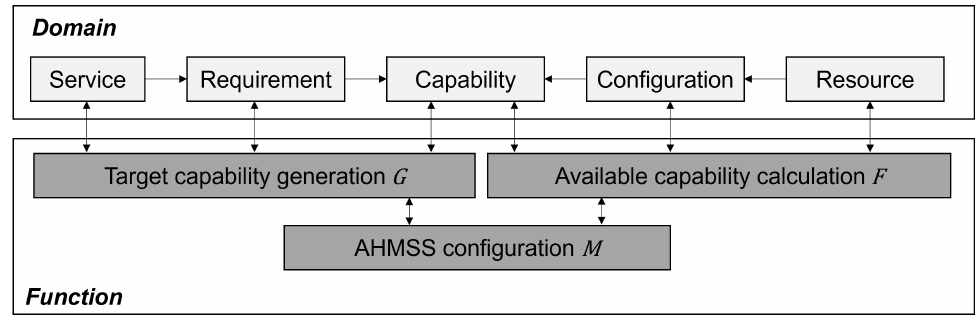
Figure 3. A domain object transitions for an AHMSS configuration, reproduced from